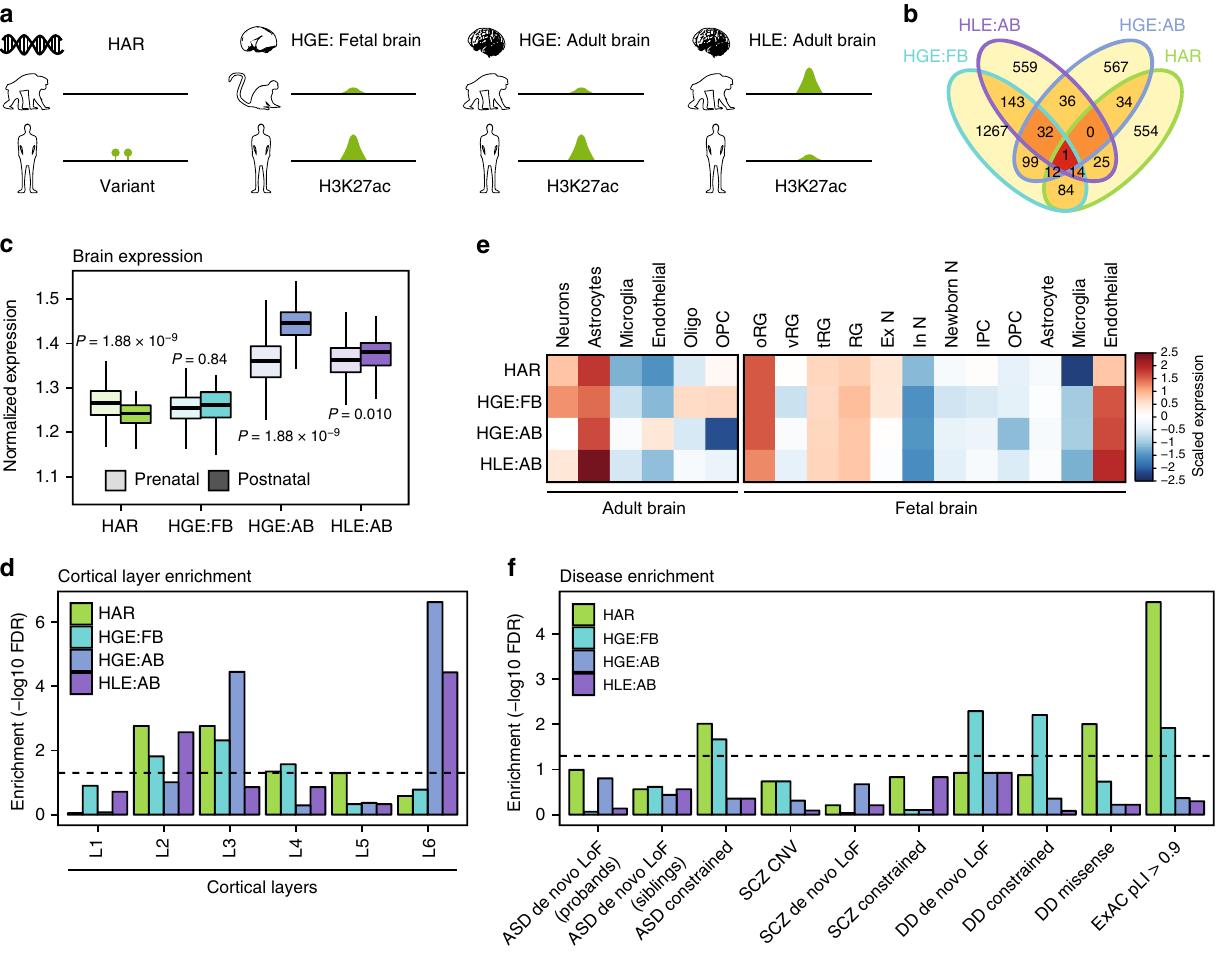
Fig. 2 Different human evolved elements regulate distinct biological pathways. a Schematic of different classes of human evolved elements. HARs were de fi ned as genomic regions with accelerated sequence changes in human; 6 HGEs FB as the genomic regions with gained enhancer activity in human compared with rhesus macaque in developing brain; 8 HGEs AB and HLEs as genomic regions with gained and lost enhancer activities in human compared with chimpanzee in adult brain, respectively 9 . b Overlap between HAR-associated genes (HAR), HGE FB -associated genes (HGE:FB), HGE AB -associated genes (HGE:AB), and HLE-associated genes (HLE). c Normalized brain expression level of genes associated with different classes of human evolved elements in prenatal and postnatal periods. FDR-adjusted P values, one-way ANOVA and post-hoc Tukey test. n = 410 and 453 for prenatal and postnatal samples, respectively. Center, median; box = 1st – 3rd quartiles (Q); lower whisker, Q1 – 1.5×interquartile range (IQR); upper whisker, Q3 + 1.5×IQR. d Laminar speci fi city of genes associated with different classes of human evolved elements. e Human evolved element-associated genes are enriched in radial glia in the developing neocortex and astrocytes in the adult PFC. Oligo, oligodendrocytes; OPC, oligodendrocyte precursor cells; RG, radial glia; oRG, outer radial glia; vRG, ventricular radial glia; tRG, truncated radial glia; Ex N, excitatory neurons; In N, inhibitory neurons; Newborn N, newborn neurons; IPC, intermediate progenitor cells. f Human evolved elements interact with neurodevelopmental disorder risk genes. Also check Supplementary Fig. 5c. OR, odds ratio; ASD, autism-spectrum disorder; SCZ, schizophrenia; DD, developmental delay; LoF, loss-of-function variation; constrained, variation in LoF variation intolerant genes (pLI > 0.9); 38 pLI, probability that a gene is intolerant to LoF variation; ExAC, Exome Aggregation Consortium. P -values